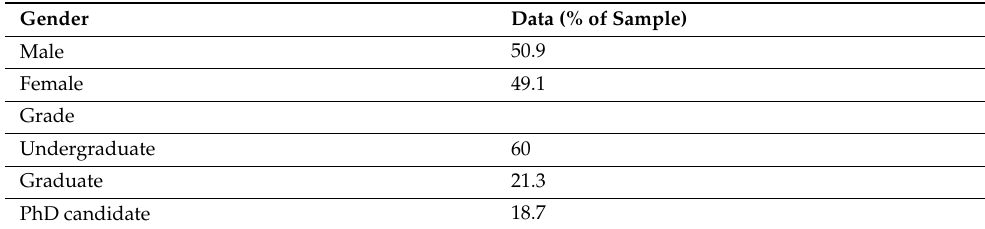
Table 1. Demographic data of the